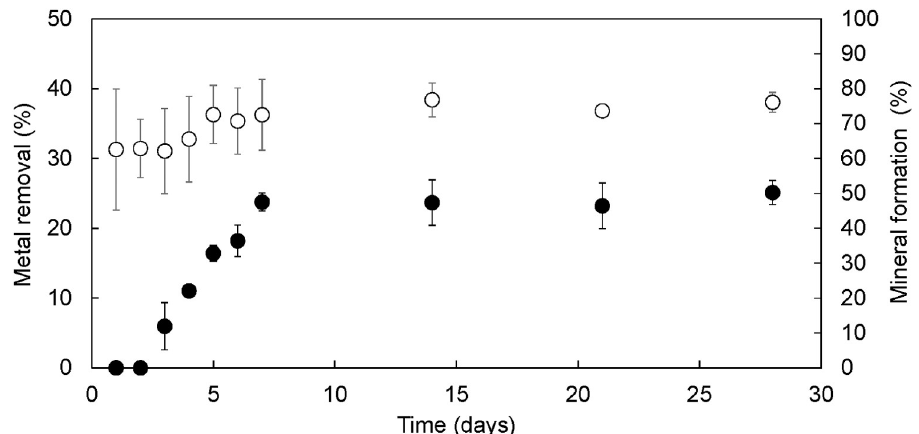
Fig 4. Time profiles of metal removal in the Cu 2+ solution (%) (open circle) and mineral formation (%) (closed circle) during long-term adsorption of Cu 2+ using phosphorylated yeast cells. Mineral formation was defined by visual assessment of the presence or absence of mineral attachment on each yeast